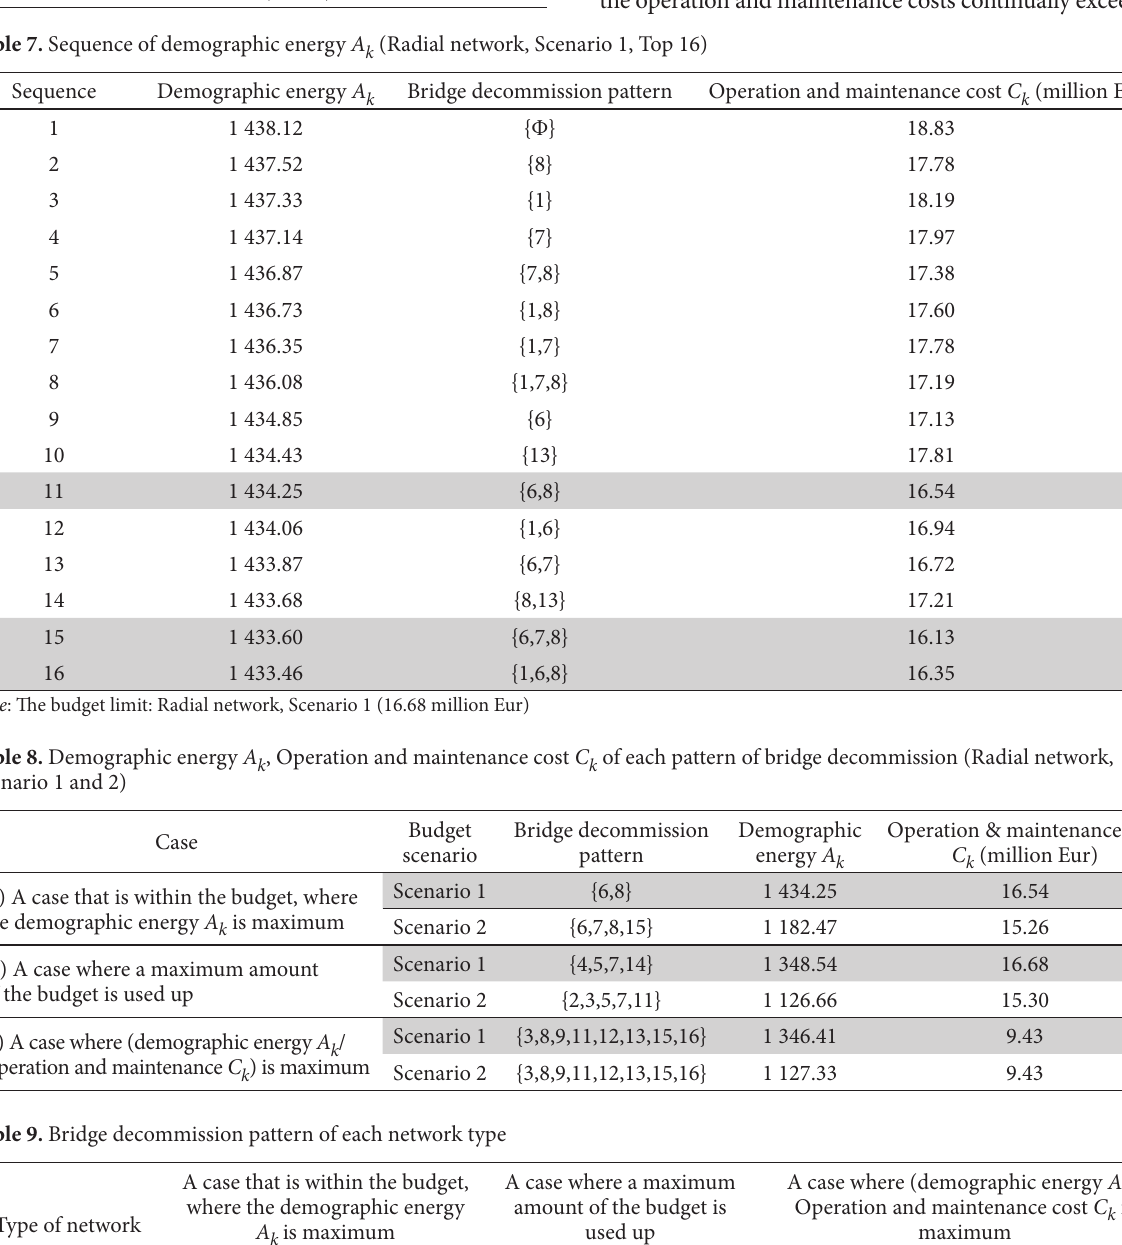
Type of network